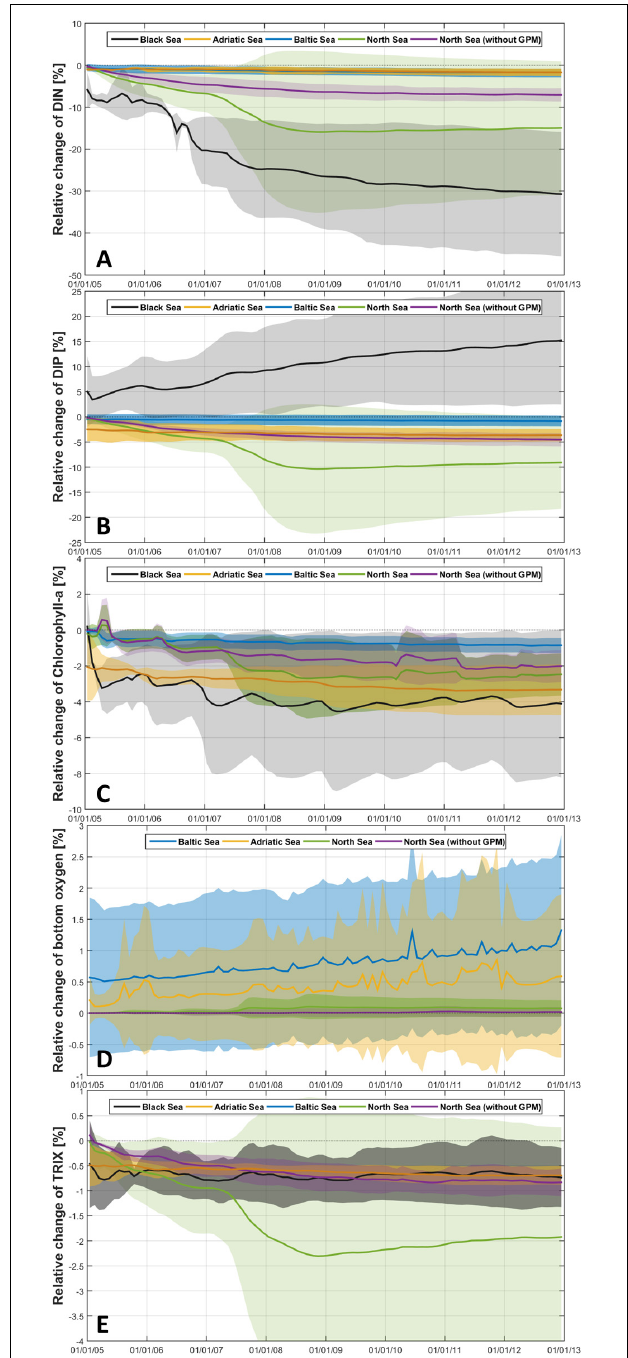
FIGURE 9 | Relative changes of DIN (A) , phosphate (B) , chlorophyll-a (C) , bottom oxygen (D) and TRIX (E) computed from the ensemble members (ensemble mean ± standard deviation) of the Black Sea (black), Adriatic Sea (yellow), Baltic Sea (blue) and North Sea including GPM (green) and without GPM (purple) following the method of Kearney